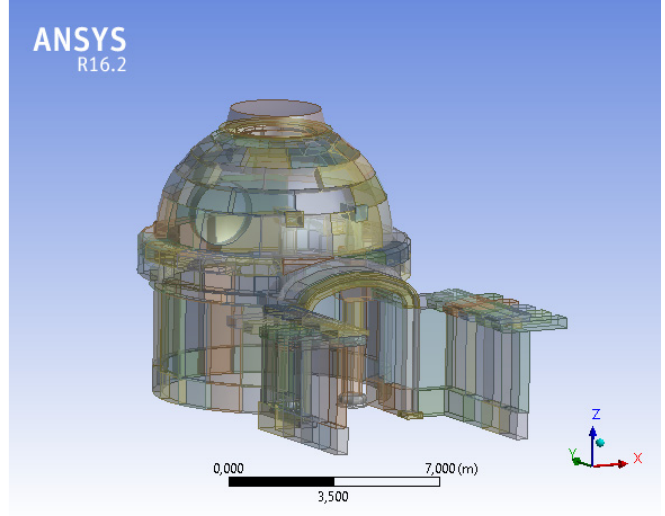
Figure 24. Process of importing the model to ANSYS.